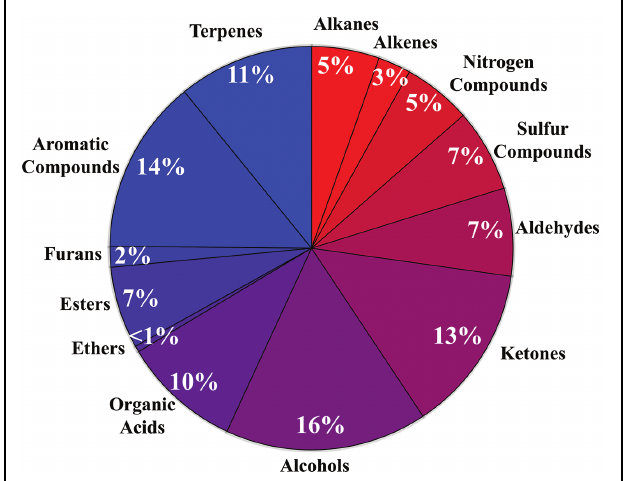
FIGURE 2 | Diversity of microbial volatiles. The 1093 volatiles from the mVOC database (Lemfack et al., 2014) grouped in chemical classes are shown as a pie